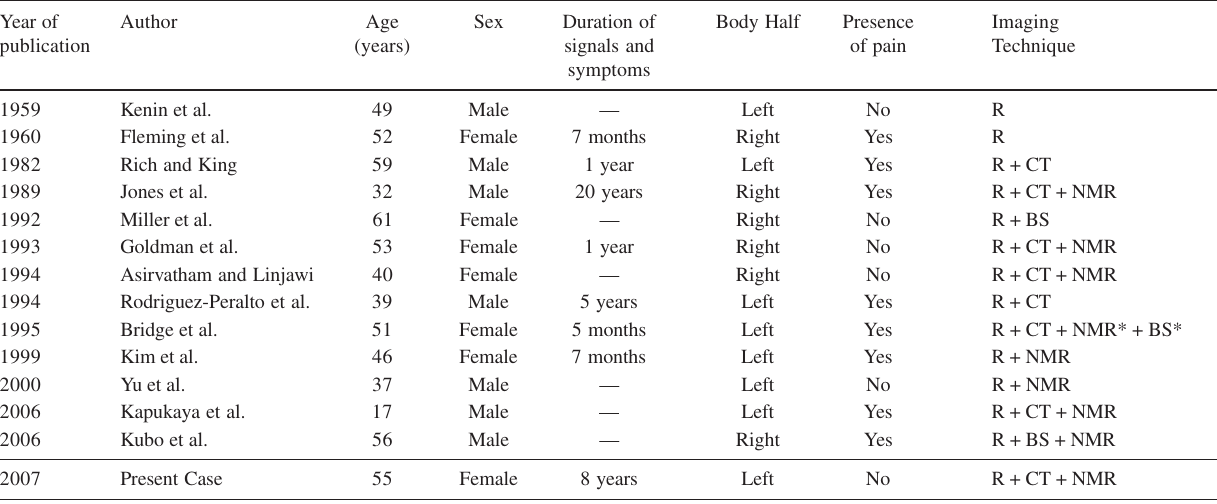
Table 1 A – Patients with parosteal lipoma of the femur with hyperostosis (identified in literature in English language) Year of